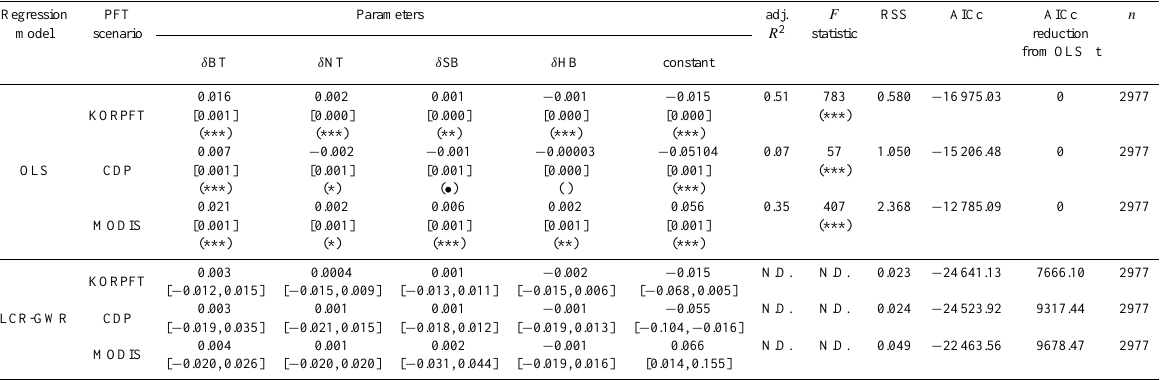
Table 4. The relationship between δ O 3 deviations and the corresponding δ PFT area across the domain derived from the OLS and LCR-GWR models. The third to seventh columns show the estimated coefficients of the explanatory variables and the intercept of the regression models. The standard errors of the coefficient estimates by OLS and the minimum and maximum values of the coefficient estimates by LCR-GWR are enclosed by square brackets. The 8th column shows the adjusted coefficient of determination representing the explanation power of the regression model. The 9th to the 11th columns show test statistics for the goodness of the regression model fits. A higher F statistic, a lower RSS, and a lower AICc value indicates better fit of the regression model and a lower p value indicates greater significance of the regression model. The 12th column shows the discrepancy of AICc between OLS and LCR-GWR fits. A higher reduction (at least over 3) indicates the greater benefits of moving from an OLS to an LCR-GWR. The 13th column shows the number of the fitted data. It should be noted that the data used for this regression analysis are from each of the individual modeling grid locations where both PFT and LAI values are not missing. The significance levels of the parameters and the model fits are (***) for p value<0.001, (**) for 0.001–0.01,